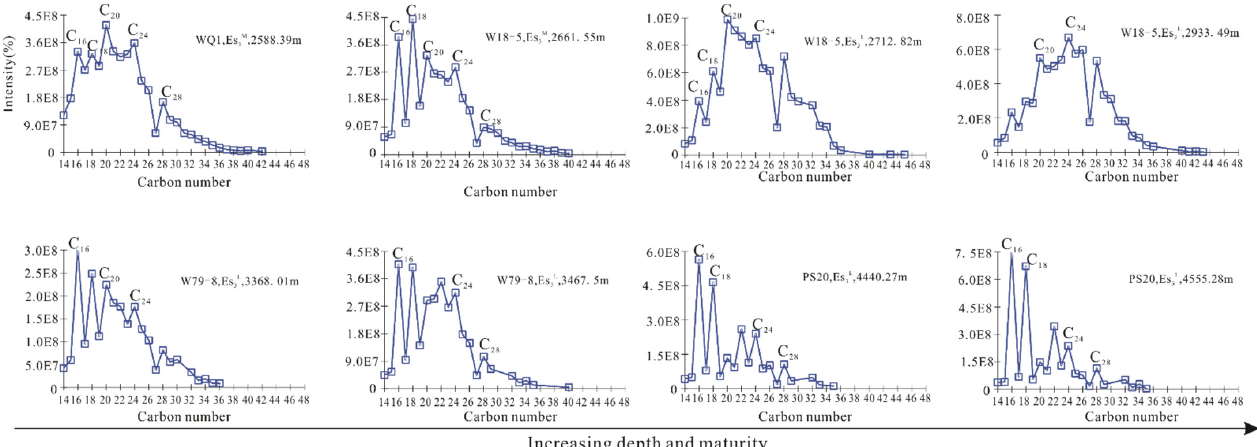
Figure 12. The intensity of analyzed samples with different carbon numbers for DBE = 1 in O 2 species by negative ion ESI FT-ICR MS.